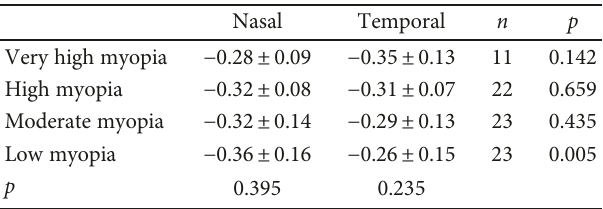
Table 2: The Q values of the anterior cornea of the adult myopia group ( n = 79 ).